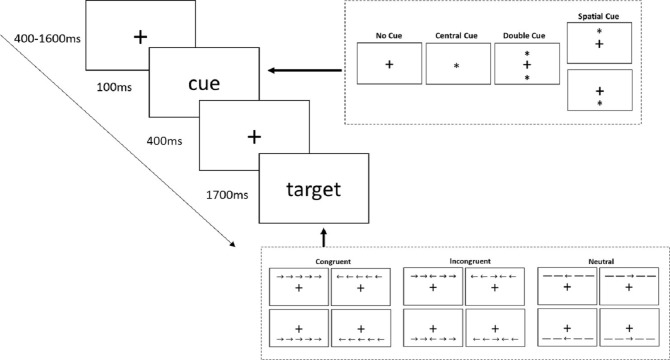
Stimuli and experimental paradigm of Attention Network Test (ANT).